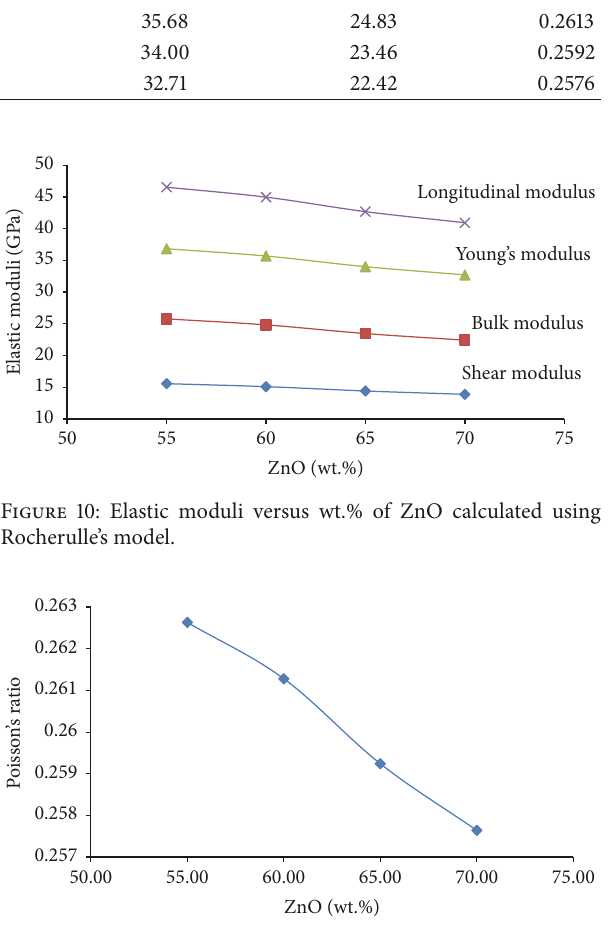
Figure 11: Poisson’s ratio versus wt.% of ZnO calculated using Rocherulle’s